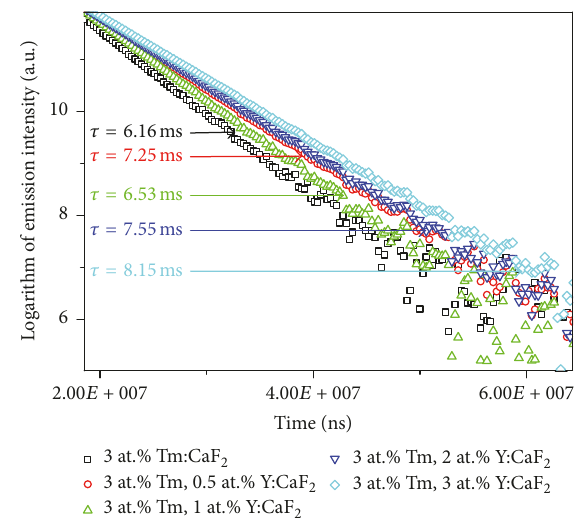
Figure 4: Fluorescence lifetimes of energy level 3 F 4 of 3 at.% Tm, 𝑥 at.% Y:CaF 2